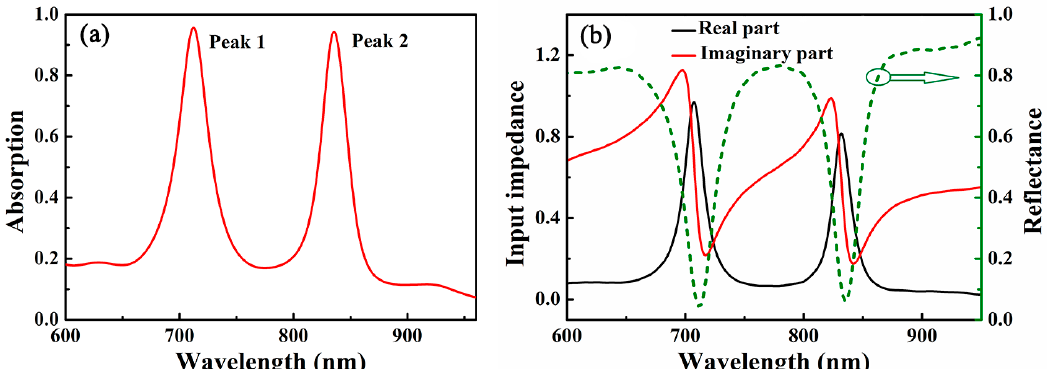
Figure 3. Optical properties of the HRA. The parameters are the same as those in Figure 1a. ( a ) Absorption response of the HRA. ( b ) Reflection response and input impedance of the HRA.